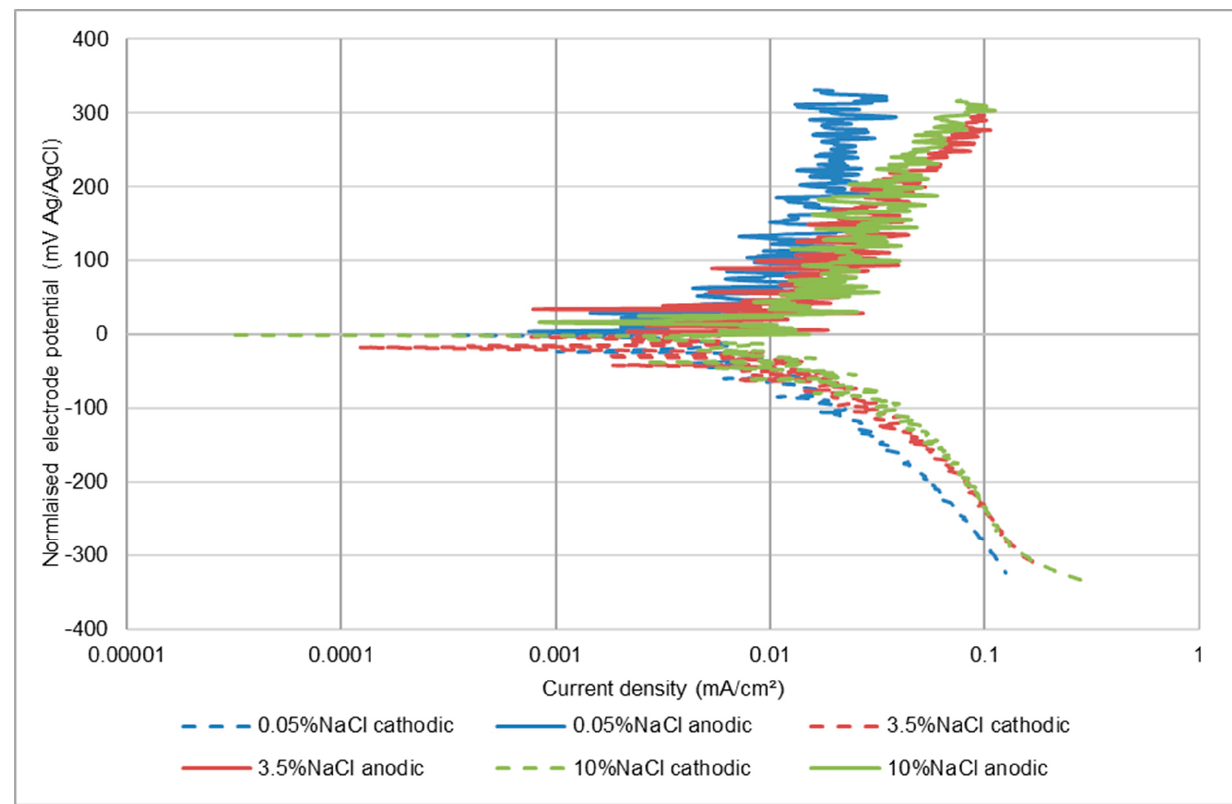
Figure 8. Polarisation plots UNS S32760 in impinging solution containing sand particles (SLEC).